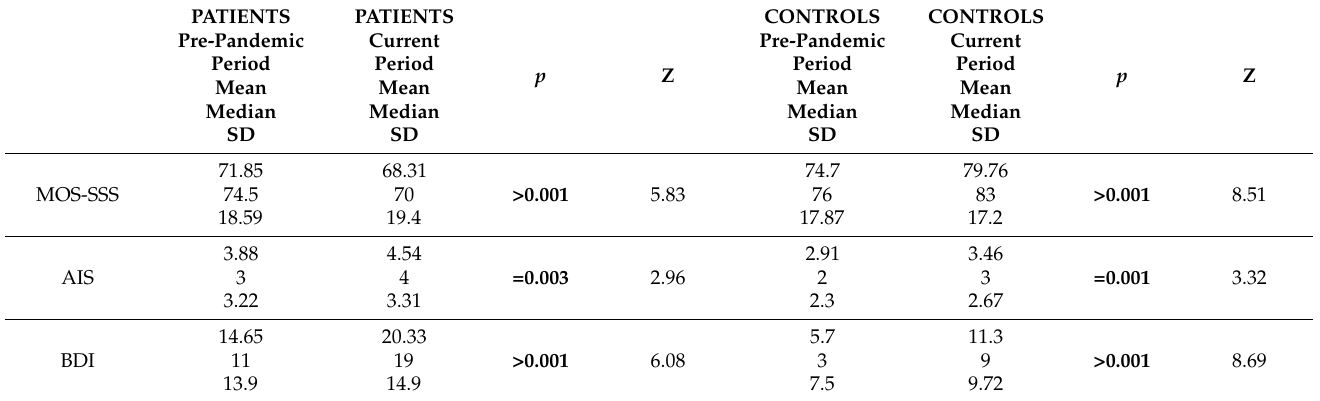
Table 1. MOS-SSS, AIS, and BDI scores reported during the pre-pandemic period and during the pandemic across groups. Wilcoxon test.